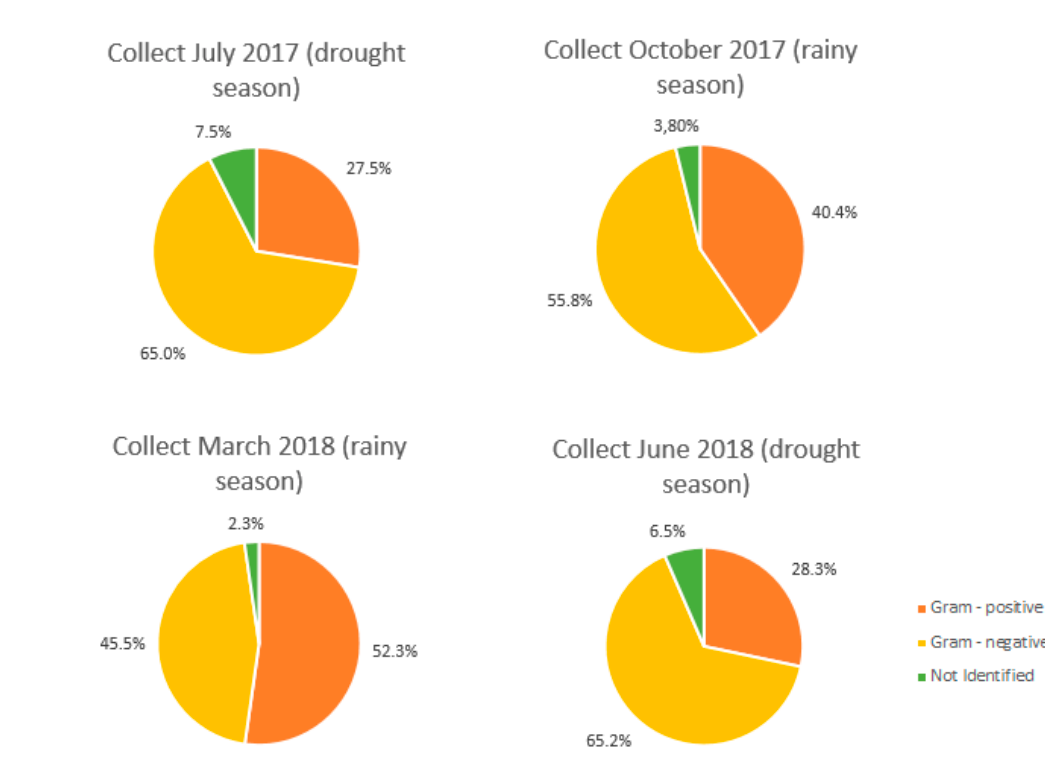
Figure 2. Distribution of isolated bacteria in Buritis Lake. Table 3. Percentage values presented by bacterial isolates from the water of Buritis Lake, in view of exposure to